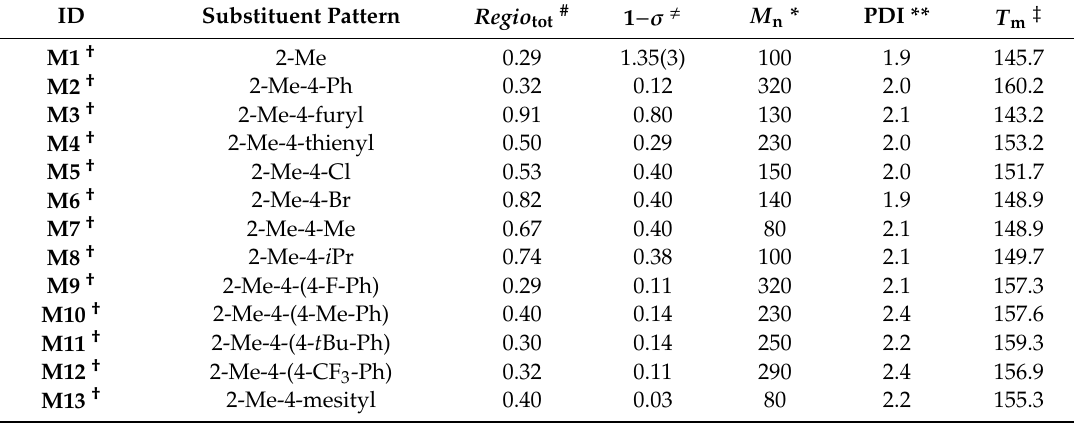
Table 1. Results of the characterization of polypropylene (PP) samples prepared at T p = 60 ◦ C and p (C 3 H 6 ) = 6.6 bar in toluene with the 38 ansa -zirconocene catalysts of Figure 1 (see text for